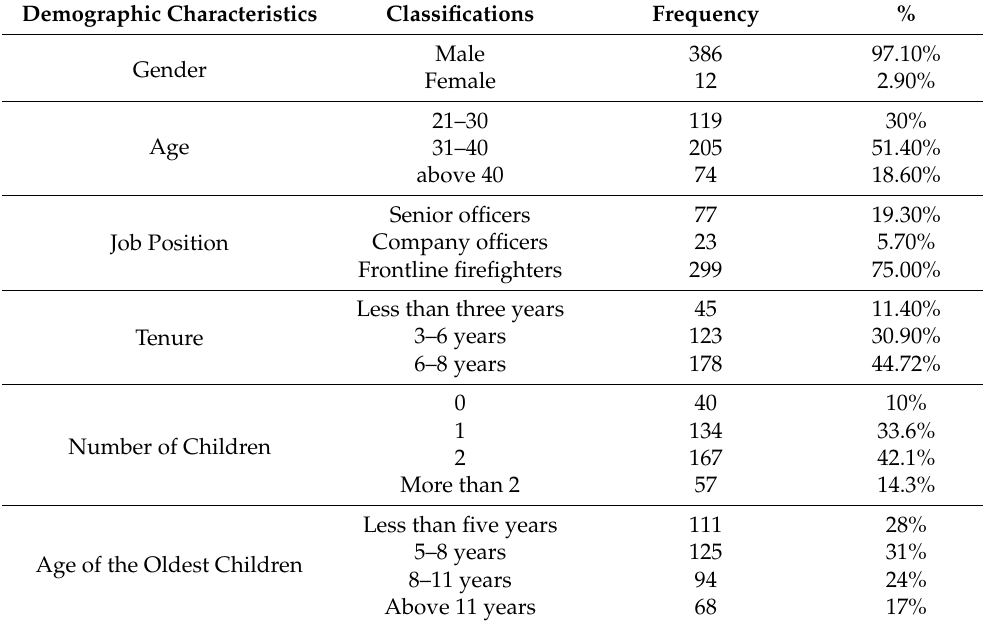
Table 1. Respondents